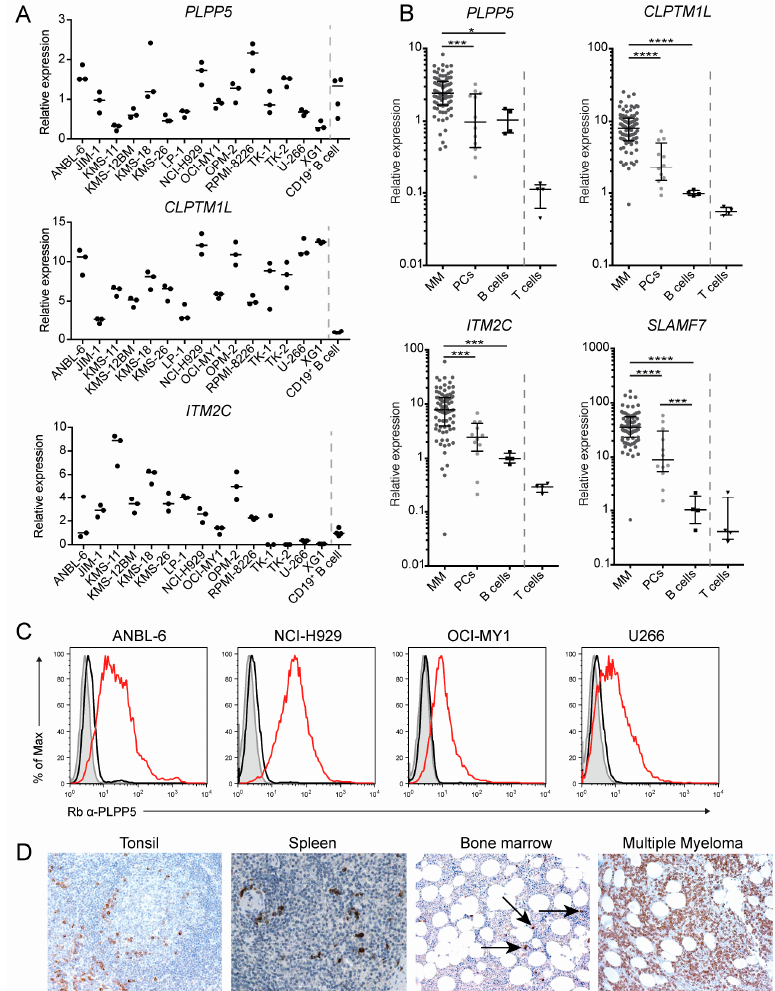
Figure 4. PLPP5 , CLPTM1L and ITM2C are expressed in human Multiple Myeloma. ( A ) Expression of PLPP5 , CLPTM1L , and ITM2C in human myeloma cell lines and primary human CD19 + B cells as determined by qPCR. Expression data was normalized by the house-keeping genes GAPDH , GPBP1 and TPT1 . Bars show median normalized expression of experimental replicates ( n = 3 myeloma cell lines, n = 4 for CD19 + primary peripheral B cells); ( B ) expression of PLPP5 , CLPTM1L, ITM2C and SLAMF7 in primary bone marrow MM samples ( n = 83), sorted plasma cells ( n = 12), peripheral blood B cells ( n = 4) and T cells ( n = 4). Expression data was normalized as in ( A ). Bars show median expression and interquartile range. One-way ANOVA with Tukey’s multiple comparison test on log transformed data from MM, plasma cells and B cells; * ( p < 0.05), *** ( p < 0.001), **** ( p < 0.0001). ( C ) cell surface expression of PLPP5 in human myeloma cell lines was determined by flow cytometry. Grey histograms: unstained cells, black lines: anti-rabbit (Rb) IgG control, red lines: Rb anti-PLPP5; ( D ) expression of CLPTM1L in human tonsil, spleen and bone marrow trephine from patients with non-Hodgkin’s Lymphoma (labeled, Bone marrow) or multiple myeloma. Spleen image was obtained from the Human Protein Atlas v18 (www.proteinatlas.org/ENSG00000049656- CLPTM1L/tissue/spleen#img). Images were captured at 100× magnification.